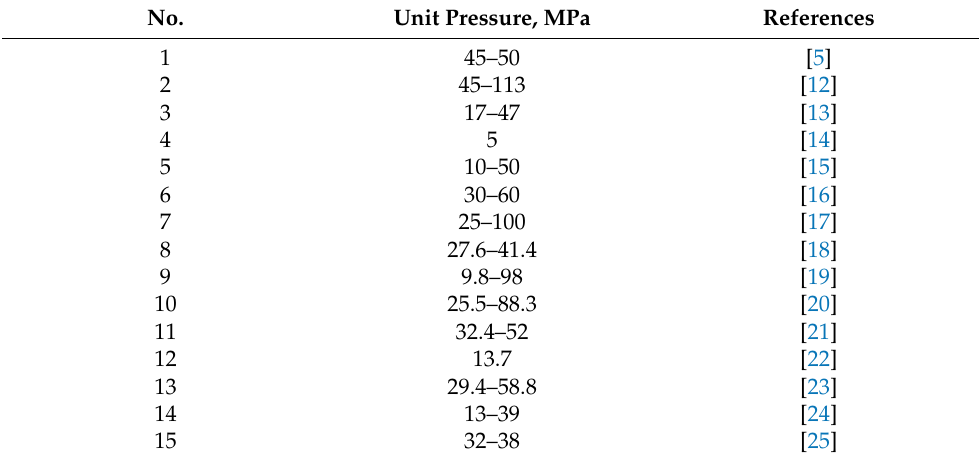
Table 1. Unit pressure values reported in the